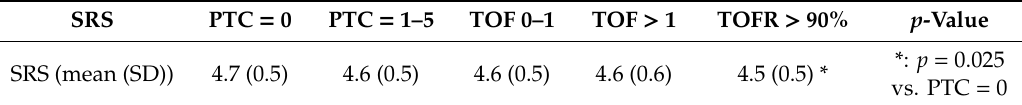
Table 5. Surgical rating scale